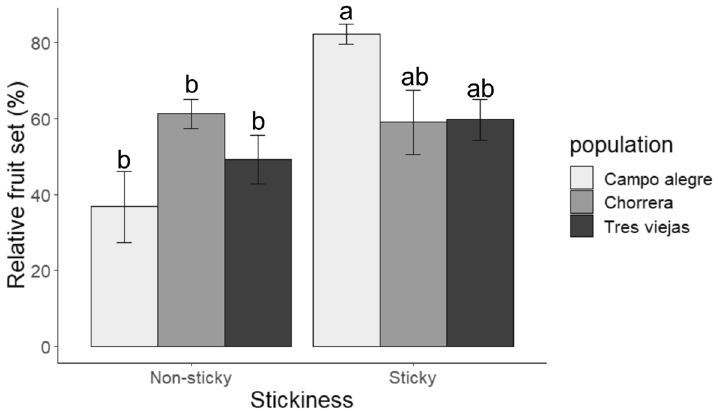
Figure 4. Mean relative fruit set (± SE) of sticky and non-sticky plants of Bejaria resinosa in three different populations. Different letters indicate significant differences (Tukey test, significance P =